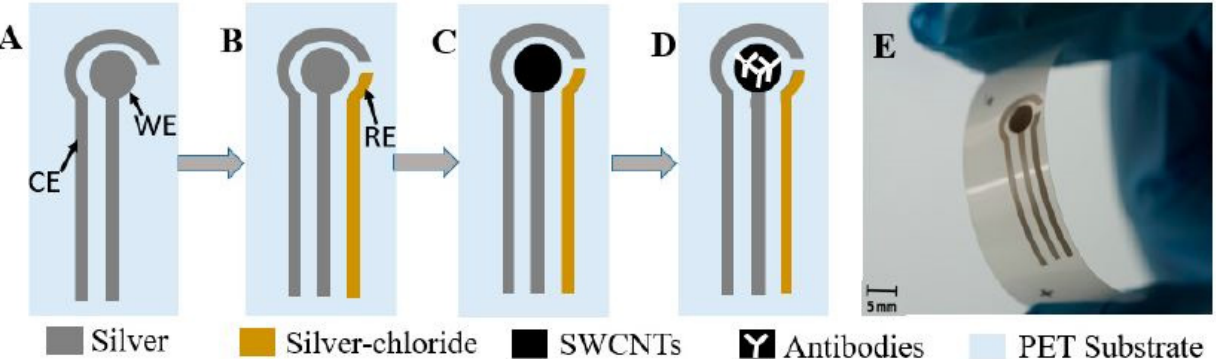
Figure 3. Schematic diagram of the fabrication process of SWCNT/PET-based biosensors [109]. ( A ) printing working electrode (WE) and counter electrode (CE), ( B ) printing WE with AgCl by alignment, ( C ) spray depositing single-walled carbon nanotubes (SWCNTs), ( D ) immobilization of antibody, and ( E ) final biosensor. Reproduced from Abera, B.D., Falco, A., Ibba, P., Cantarella, G., Petti, L. and Lugli, P., 2019. Development of flexible dispense-printed electrochemical immunosensor for aflatoxin M1 detection in milk. Sensors , 19 (18), p. 3912.